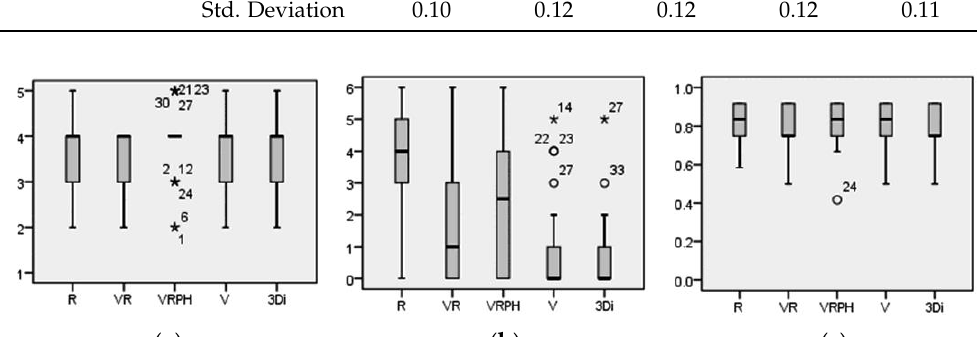
Figure 5. Box plots for the semantic scales. Outliers outside 1.5 times the interquartile range above the upper quartile and below the lower quartile are represented by an open circle. Extreme outliers are marked with an asterisk.